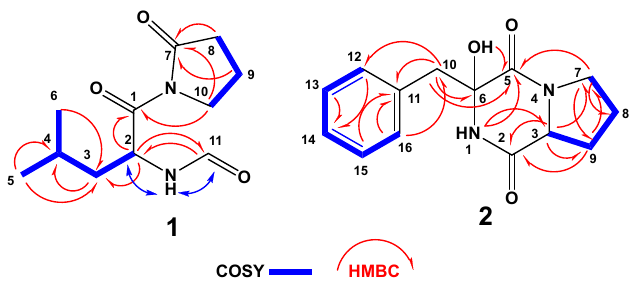
Figure 2. Key COSY and HMBC correlations of 1 and 2 .